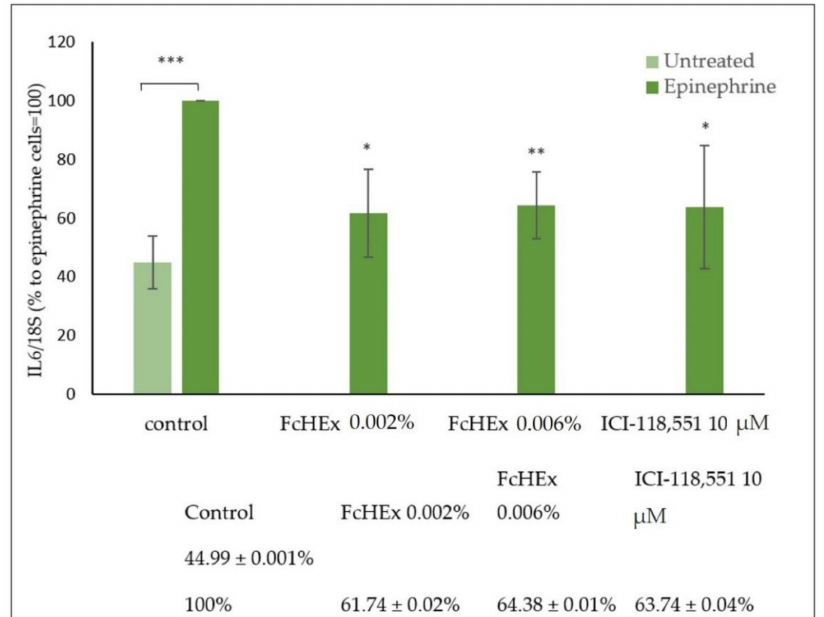
Figure 2. Effect of the FcHEx on the IL-6 gene expression in the skin keratinocytes. The keratinocytes were stimulated with 10 µ M of epinephrine alone or with the FcHEx or the positive control for 4 h and then processed for RT-PCR analysis. The reported values represent the averages of three independent experiments and are expressed as the percentages of cells treated with epinephrine only, which was set to 100%. The asterisks indicate statistically significant values (*** p -value was between 0.0001 and 0.001; ** p -value wa between 0.001 and 0.01; * p -value was between 0.01 and